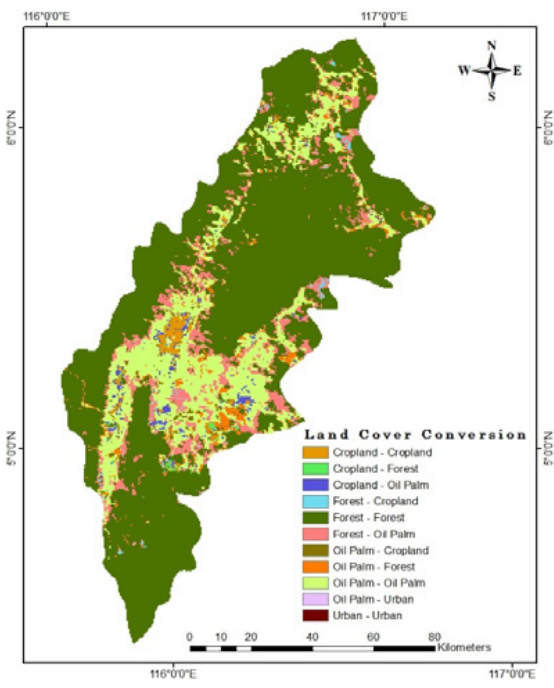
Fig. 6: Land cover conversion of study areas from the year 2005 to 2019 Table 3: Cross‐tabulation of land cover change between the year 2005 to 2019 Land cover class area (km 2 )